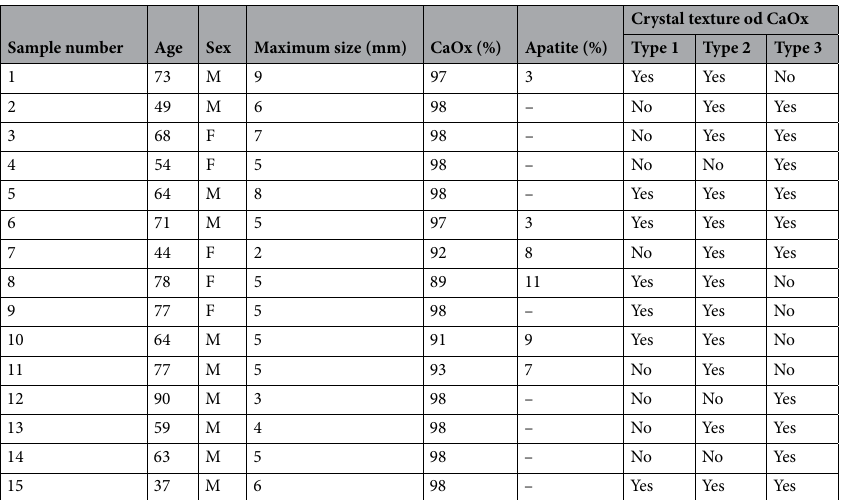
Table 1. Summary of the patient demographic, maximum size of the stone, ratio of the mineral phase. CaOx calcium oxalate, Type1: idiomorphic COD, Type2: mosaic texture composed of irregular oriented COM, and Type3: concentrically laminated